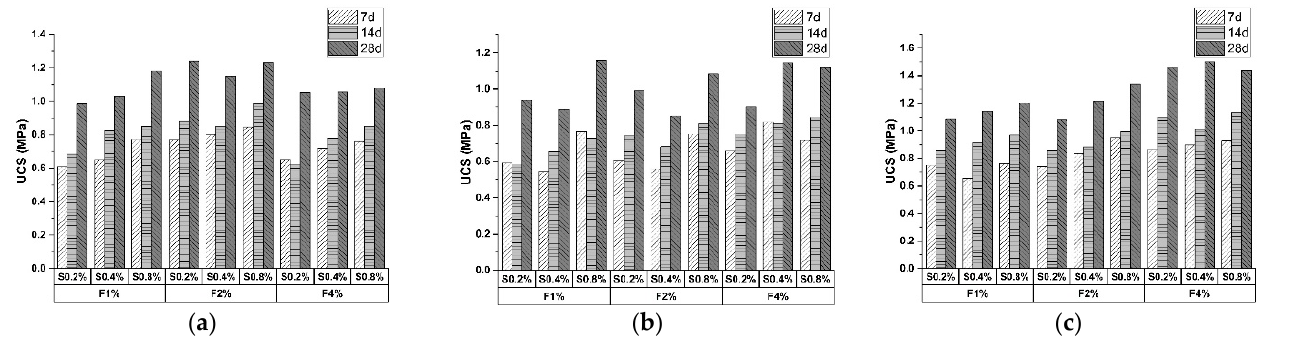
Figure 3. Unconfined compressive strength of 20% cement specimen with ( a ) 10% C&D waste; ( b ) 20% C&D waste; ( c ) 30% C&D waste (Note: S represents sodium sulfate; F represents polypropylene fiber).